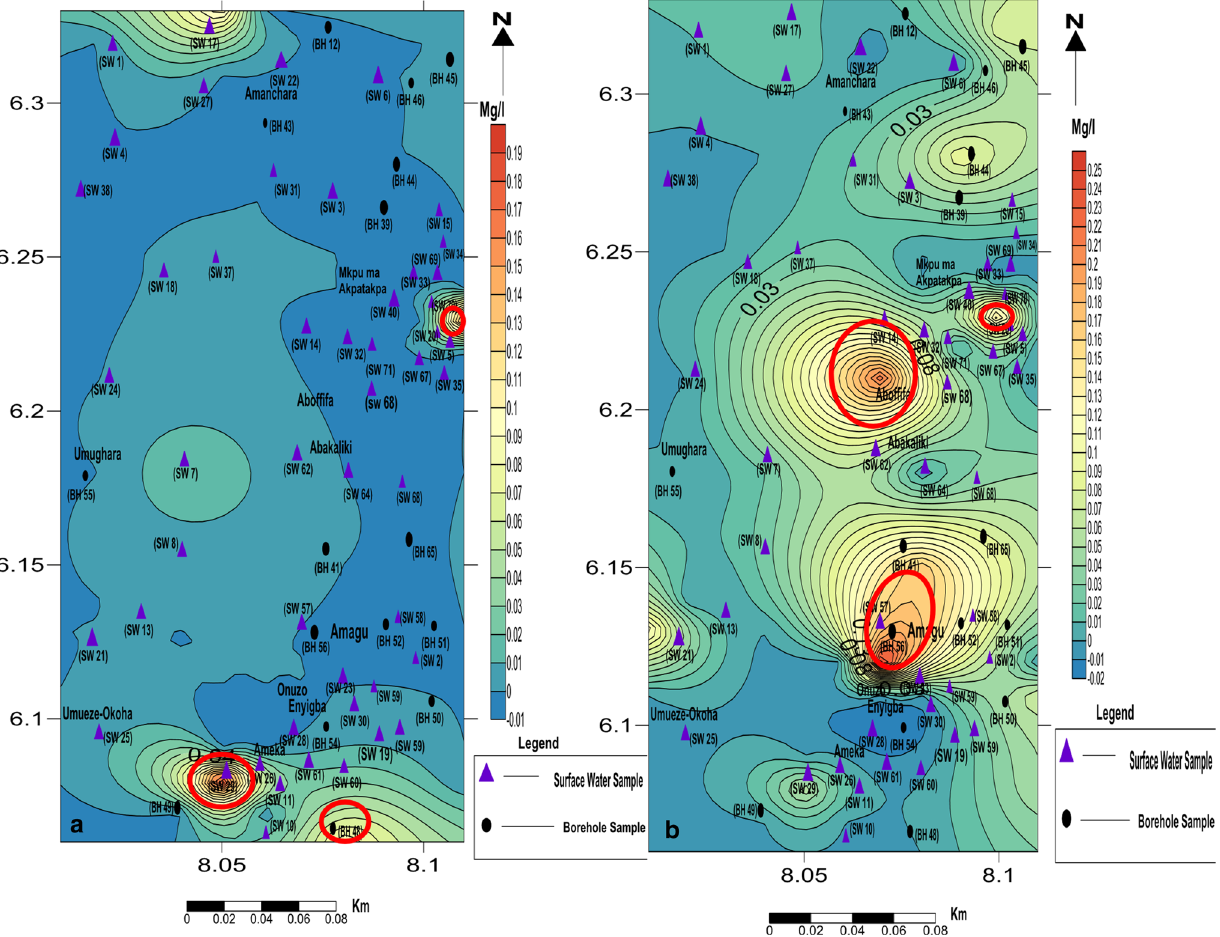
Fig. 3 Distribution of a chromium, b nickel showing potentially high risk areas (as highlighted in red